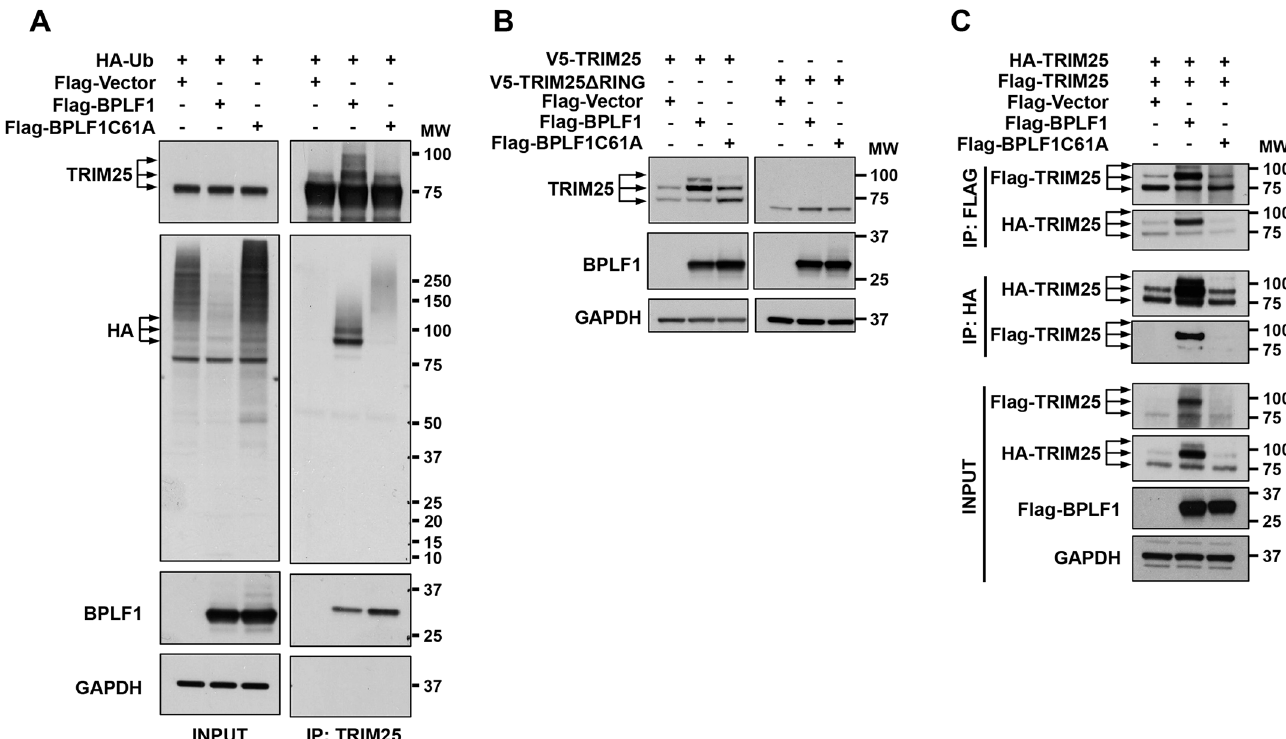
Fig 5. BPLF1 promotes TRIM25 dimerization and auto-ubiquitination. A . Catalytically active BPLF1 promotes TRIM25 ubiquitination. HA-Ub was co- transfected in HeLa cells together with the indicated FLAG-tagged plasmids. Cell lysates were immunoprecipitated with the anti-TRIM25 antibody, and immunoblotted with anti-HA antibodies. Unmodified, mono- and di-ubiquitinated TRIM25 species are indicated by arrows. One representative experiment out of 3 is shown. B . BPLF1 induces TRIM25 auto-ubiquitination. HeLa cells were transfected with either V5-TRIM25 or V5-TRIM25 Δ RING together with the indicated FLAG-tagged plasmids. Total cell lysates were probed with an anti-V5 antibody. Unmodified, mono- and di-ubiquitinated TRIM25 species are indicated by arrows. One representative experiment out of 2 is shown. C . Active BPLF1 promotes the dimerization and functional activation of TRIM25. HeLa cells were co- transfected with the indicated FLAG-tagged plasmids and with HA- and FLAG-tagged TRIM25. Western blots of HA and FLAG immunoprecipitates were probed with antibodies to the HA and FLAG tags. One representative experiment out of 3 is shown.